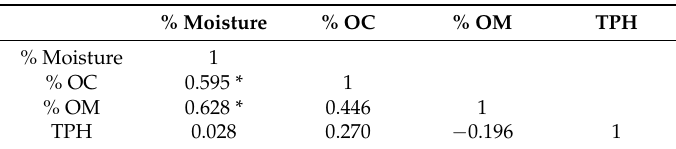
Table 8. Pearson correlations among the sediments quality